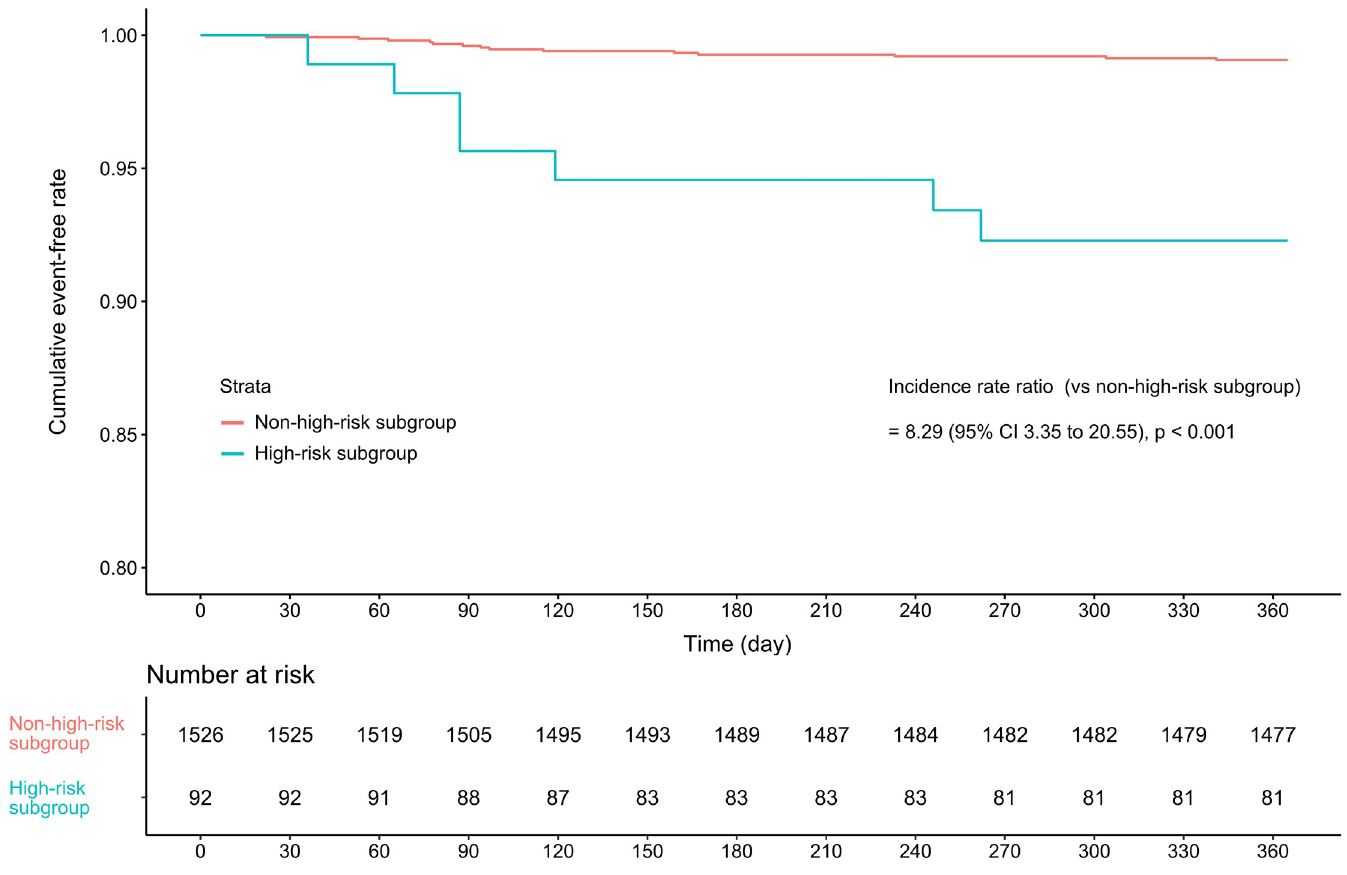
Fig 1. Kaplan–Meier curves indicating the 1-year tuberculosis incidence according to the presence of high-risk factors.